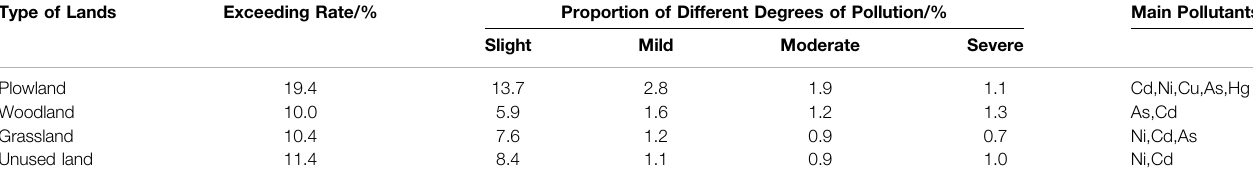
TABLE 2 | Soil environmental quality of different land in China. Type of